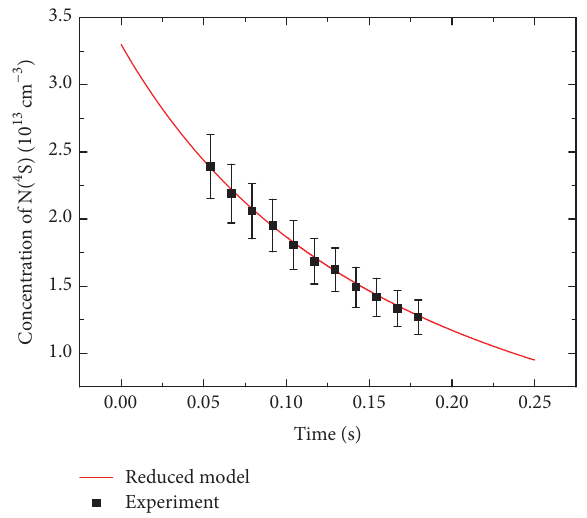
Figure 7: Fit of the kinetic model of the pure nitrogen after- glow given by reduced reactions from Table 1 to the experimental data, giving the previously unknown initial value [ N ( 4 S )] 0 = 3.3 ⋅ 10 13 cm −3 and the value of 𝑘 2